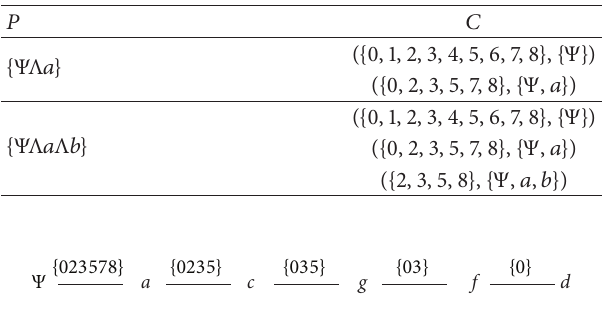
Figure 6: The current path 𝑃 = {ΨΛ𝑎Λ𝑐Λ𝑔Λ𝑓Λ𝑑} .